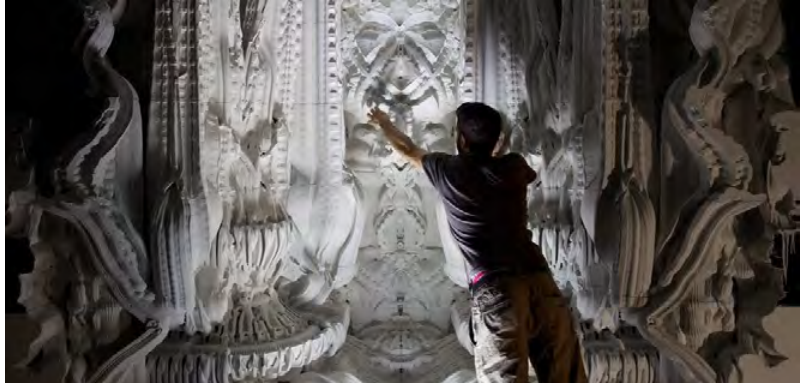
Figure 14. The Intricate Grotesque after finishing and it shows a new phase in additive manufacture and its impact on architecture leading to generate classic forms though the processing phase was computationally done